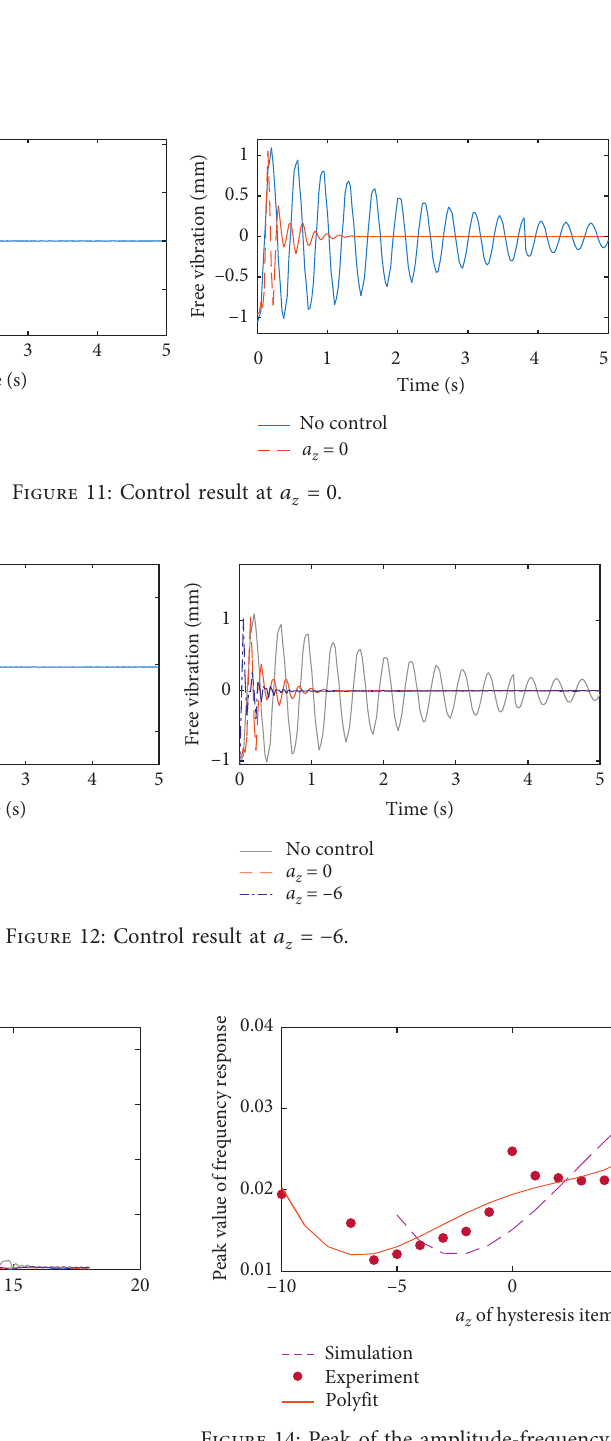
Figure 13: Amplitude-frequency characteristic of the free vibration.